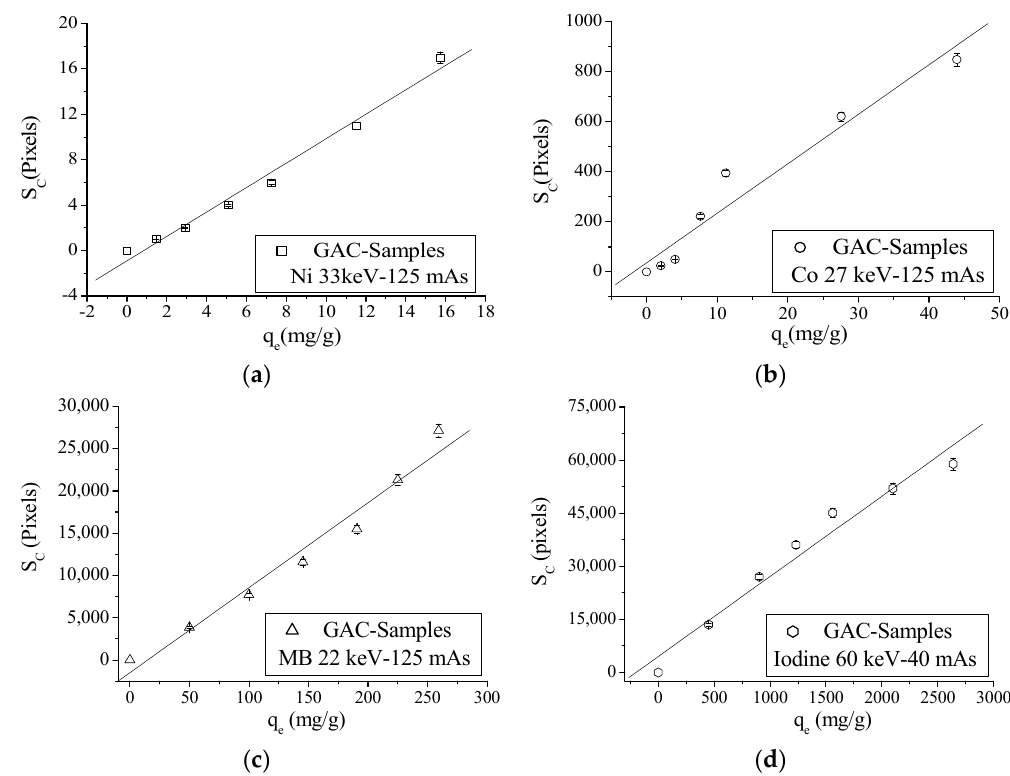
Figure 5. Correlation graphs between S C and q e values: ( a ) nickel; ( b ) cobalt; ( c ) MB; and ( d ) Iodine for virgin GAC and ion or molecule loaded GAC samples.